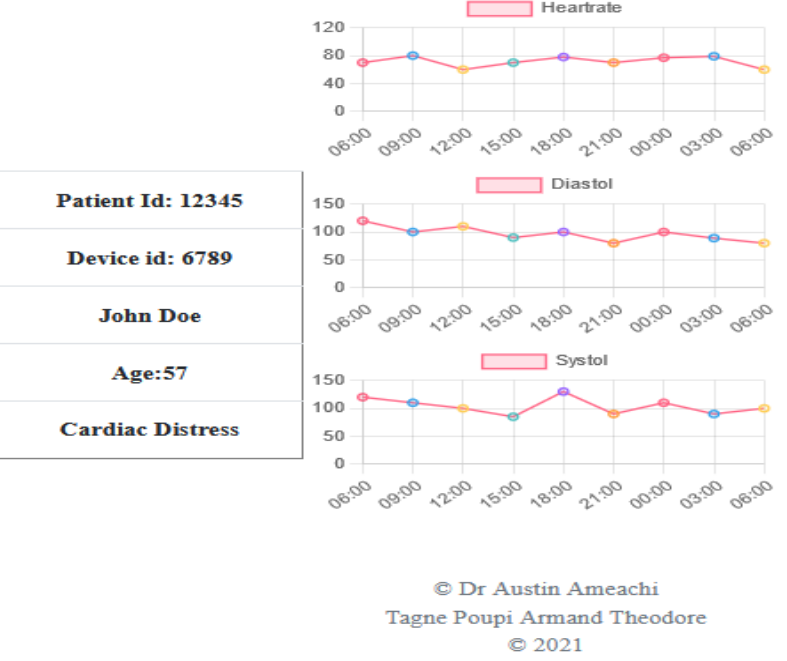
Figure 7. Patient’s records view from the DB.